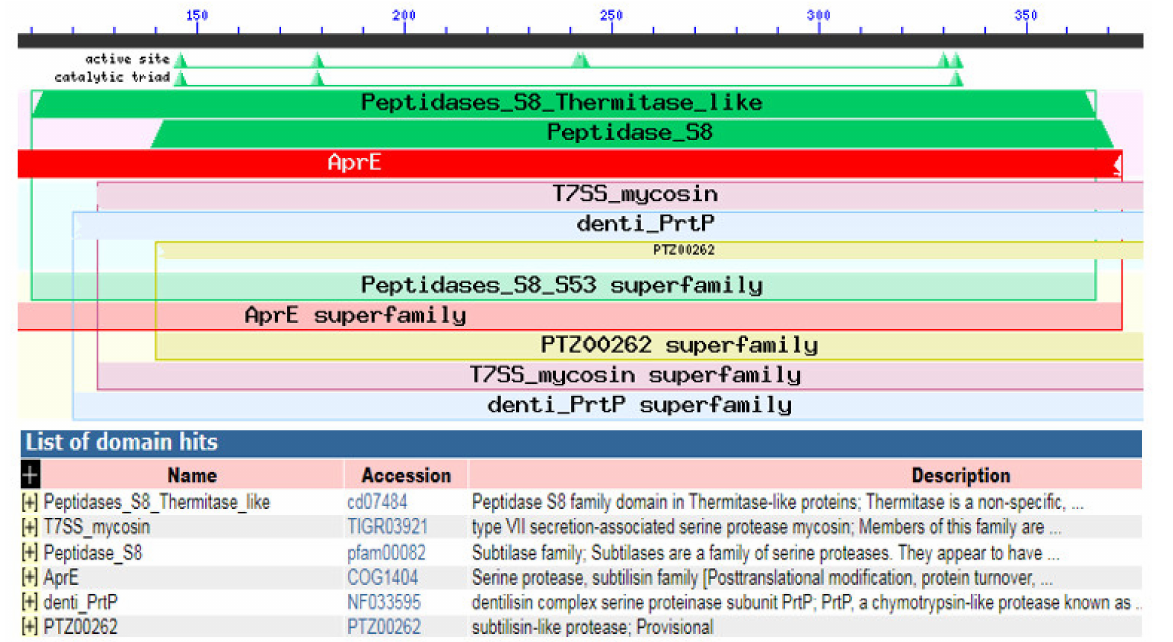
Figure 11. NCBI conserved domains search analysis showing the similarity between our KerS gene and peptidases S8